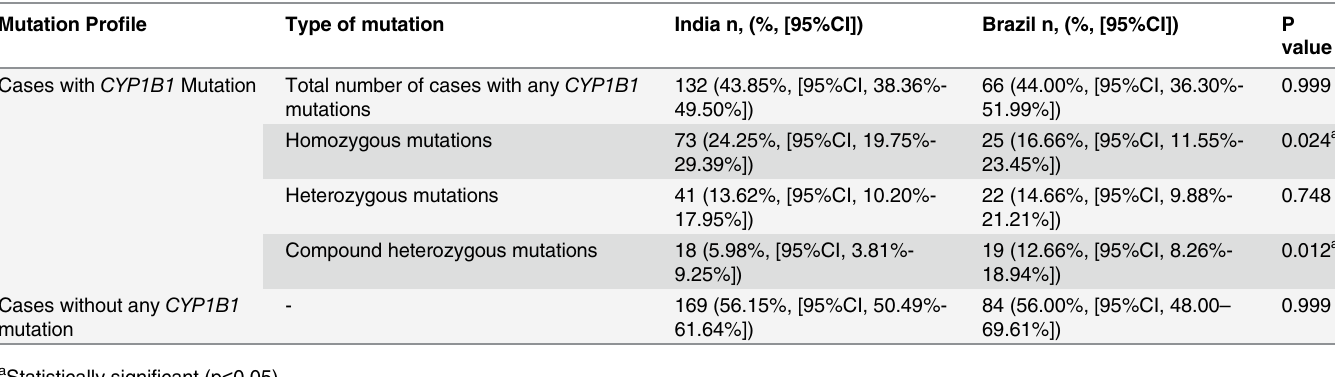
Table 2. Distribution of CYP1B1 mutations in India and Brazil.